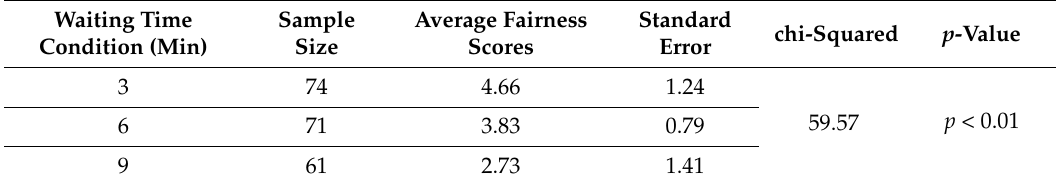
Table 1. Perceived fairness.